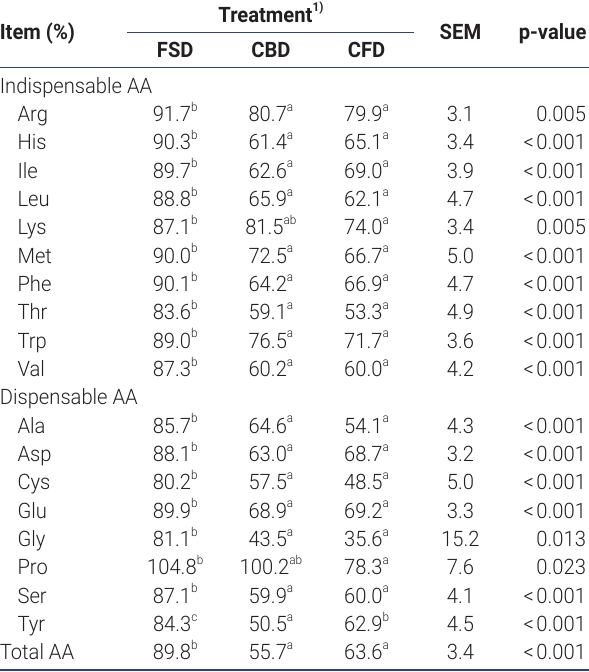
Table 6. Standardized ileal digestibility of amino acids in experimen- tal diets